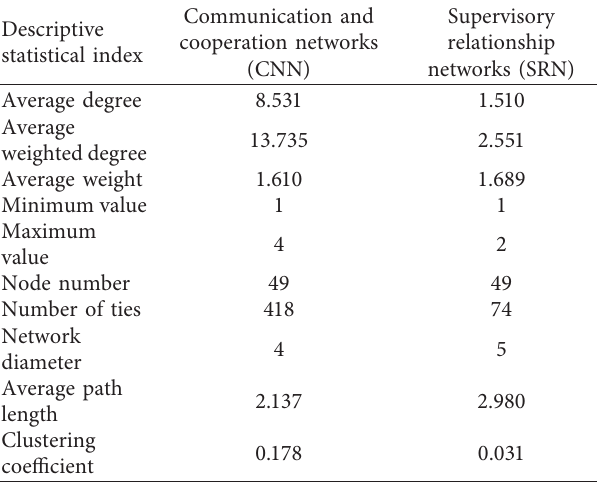
Table 2: Project descriptive